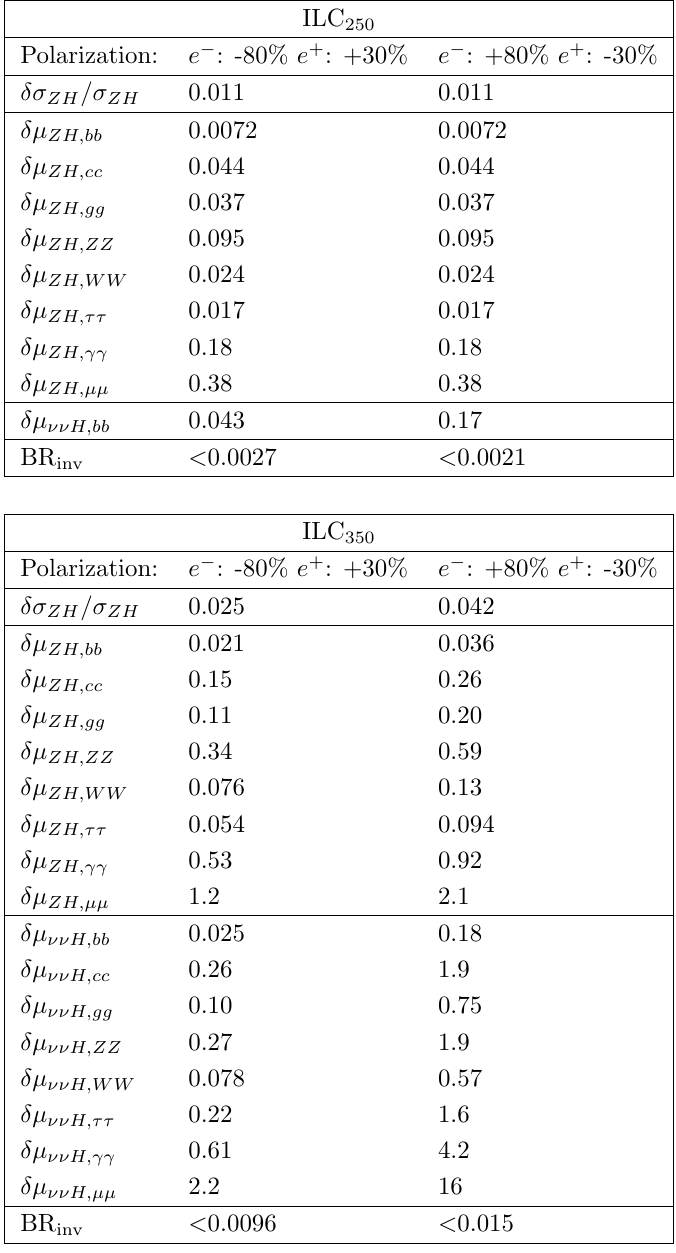
Table 21 . Inputs used for ILC projections at the 250 and 350 GeV energy stages and two polari- sations. All uncertainties are given as fractional 68% CL intervals and are taken to be symmetric. The upper limits are given at 68% CL.